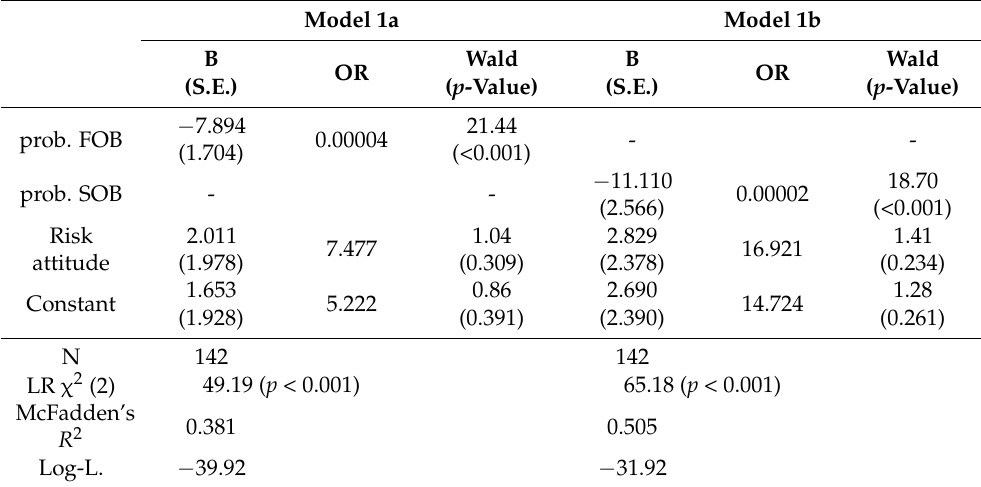
Table 4. Results of the logit regression analyses predicting strategy